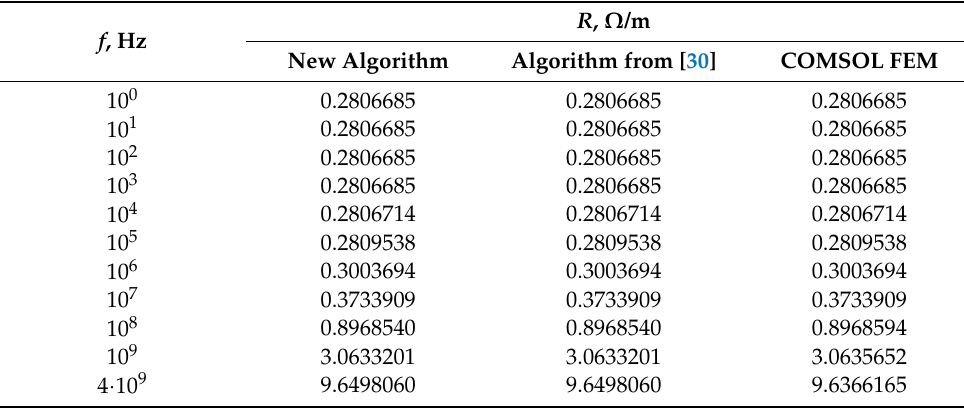
Table 2. Comparison of the resistance p.u.l. for the first validation